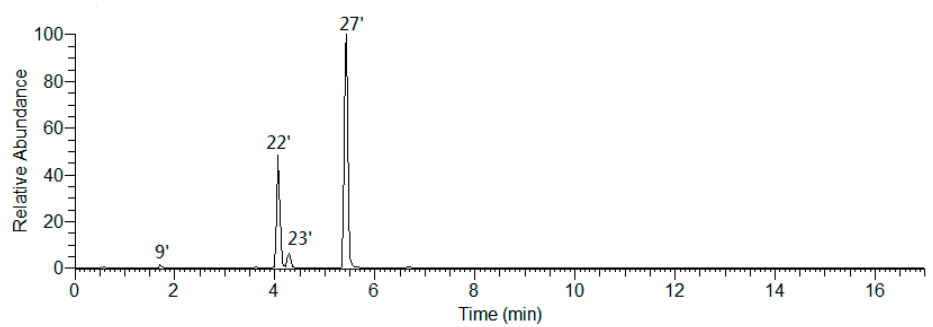
Figure 10. The EIC of the m/z 771.19783.